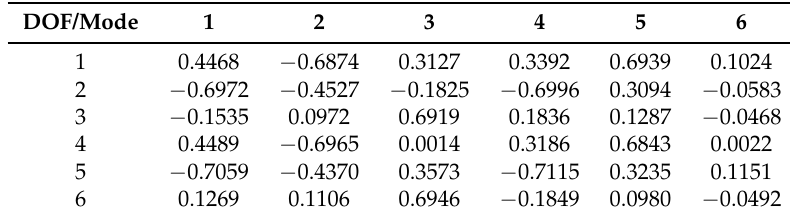
Table 6. Real modes of the lattice tower structure used in simulation examples.